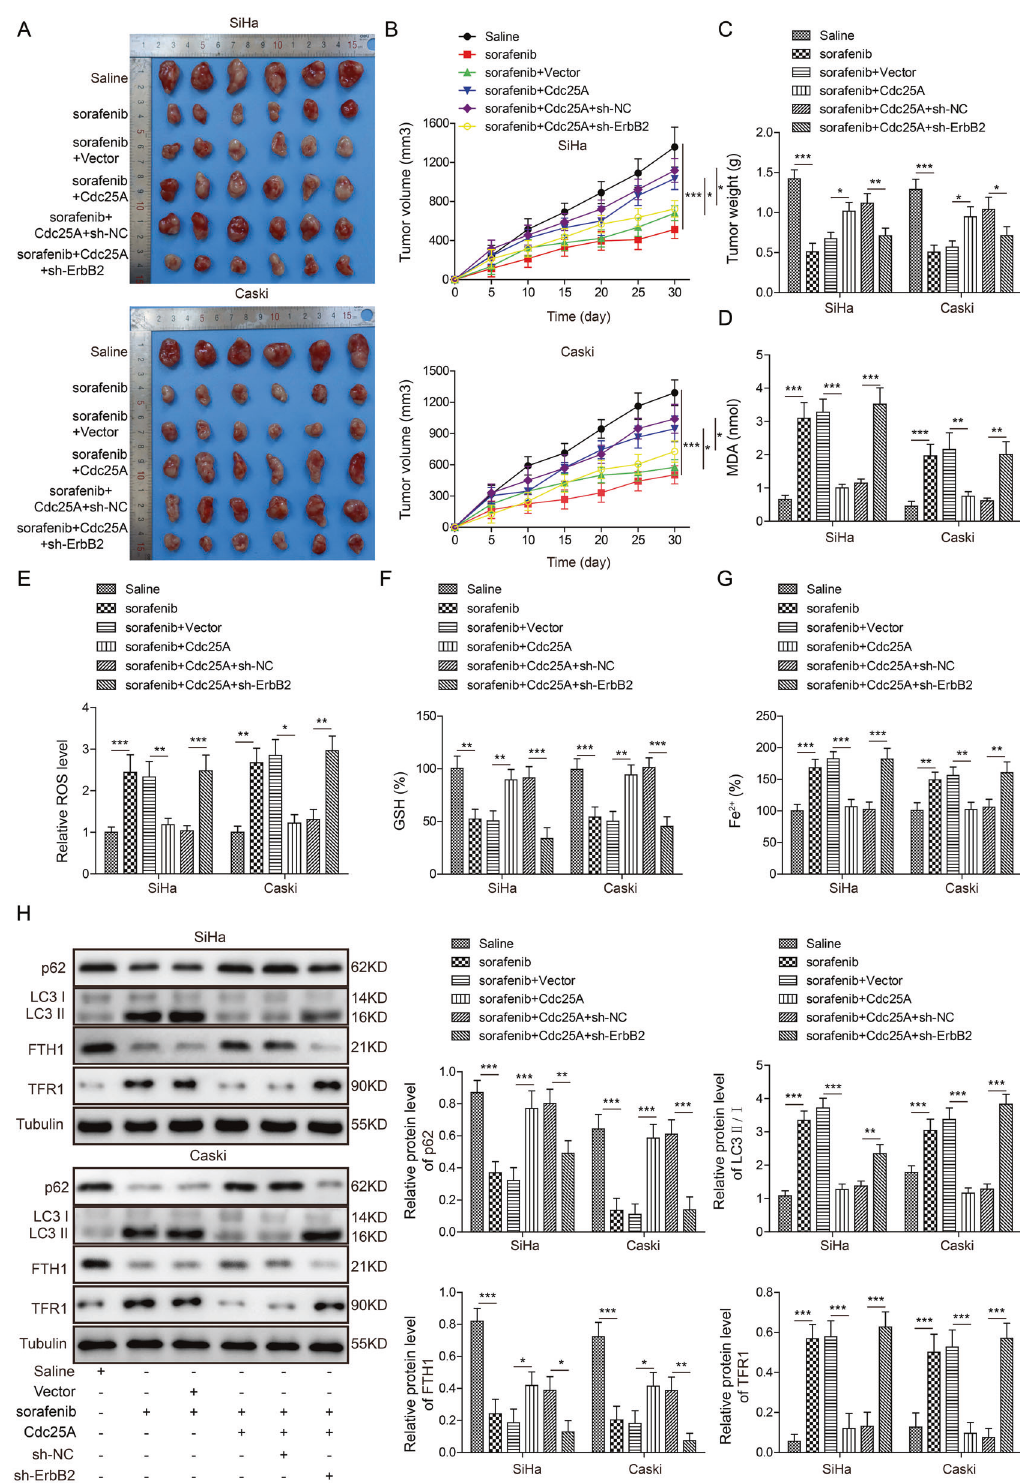
Fig. 8 Cdc25A increased the resistance of cervical carcinoma to sorafenib in vivo. A Representative image of tumours from each group of mice. N = 6 in each group. B Relative tumour volume with time in each group of mice. C Tumour weight in each group of mice. D Cellular MDA levels in tumours from each group of mice. E Cellular ROS levels in tumours from each group of mice. F Cellular GSH levels in tumours from each group of mice. G Cellular iron levels in tumours from each group of mice. H Relative protein levels of p62, LC3-I, LC3-II, FTH1, and TFR1 in tumours from each group of mice. Each experiment was repeated three times. * P < 0.05; ** P < 0.01; *** P <